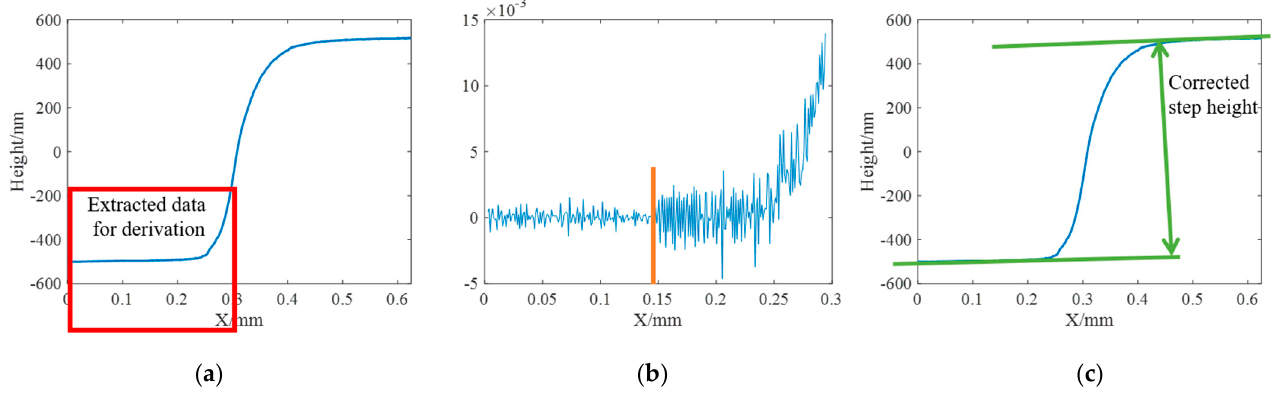
9 of 14 Figure 12. Height − error due to tilt (red horizontal line: the coated area, green horizontal line: the uncoated area, blue line: step height profile). Thus, the question of how to confirm the degree of tilt is critical. Since the surface of the wafer used was ultra-smooth, the height profile of the surface was very flat in the area without any film coating. When the film was coated, the surface height fluctuations in- creased significantly because of rapid changes in surface height. It can be clearly seen in Figure 13b that the first derivative of the step height starts to change abruptly at x = 0.15